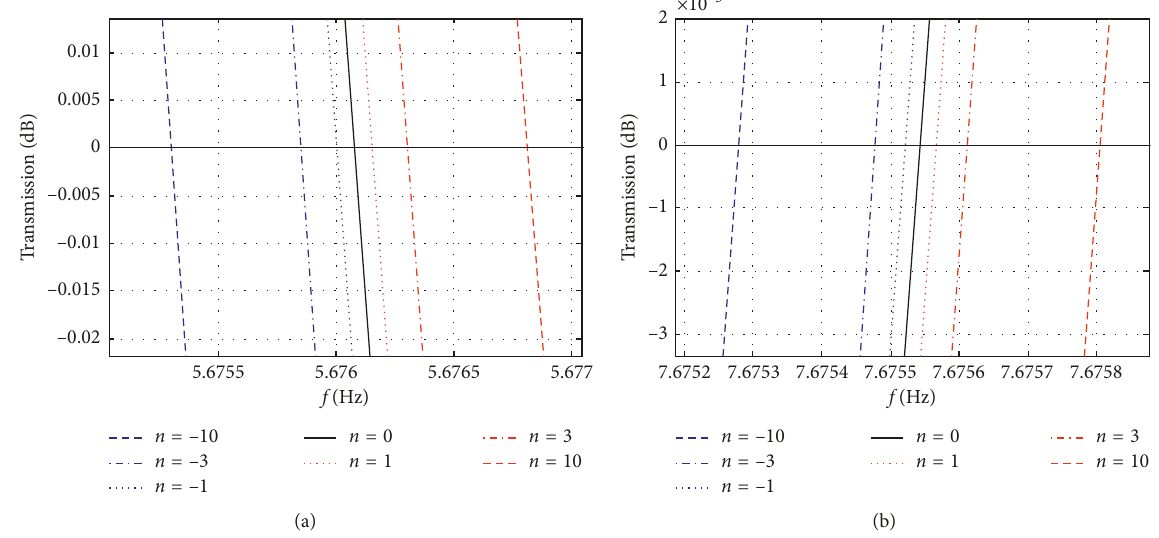
Figure 6: Starting and cutoff frequencies region ( K